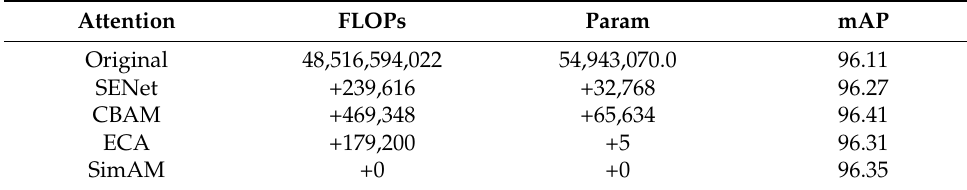
Table 3. Comparison of different attention